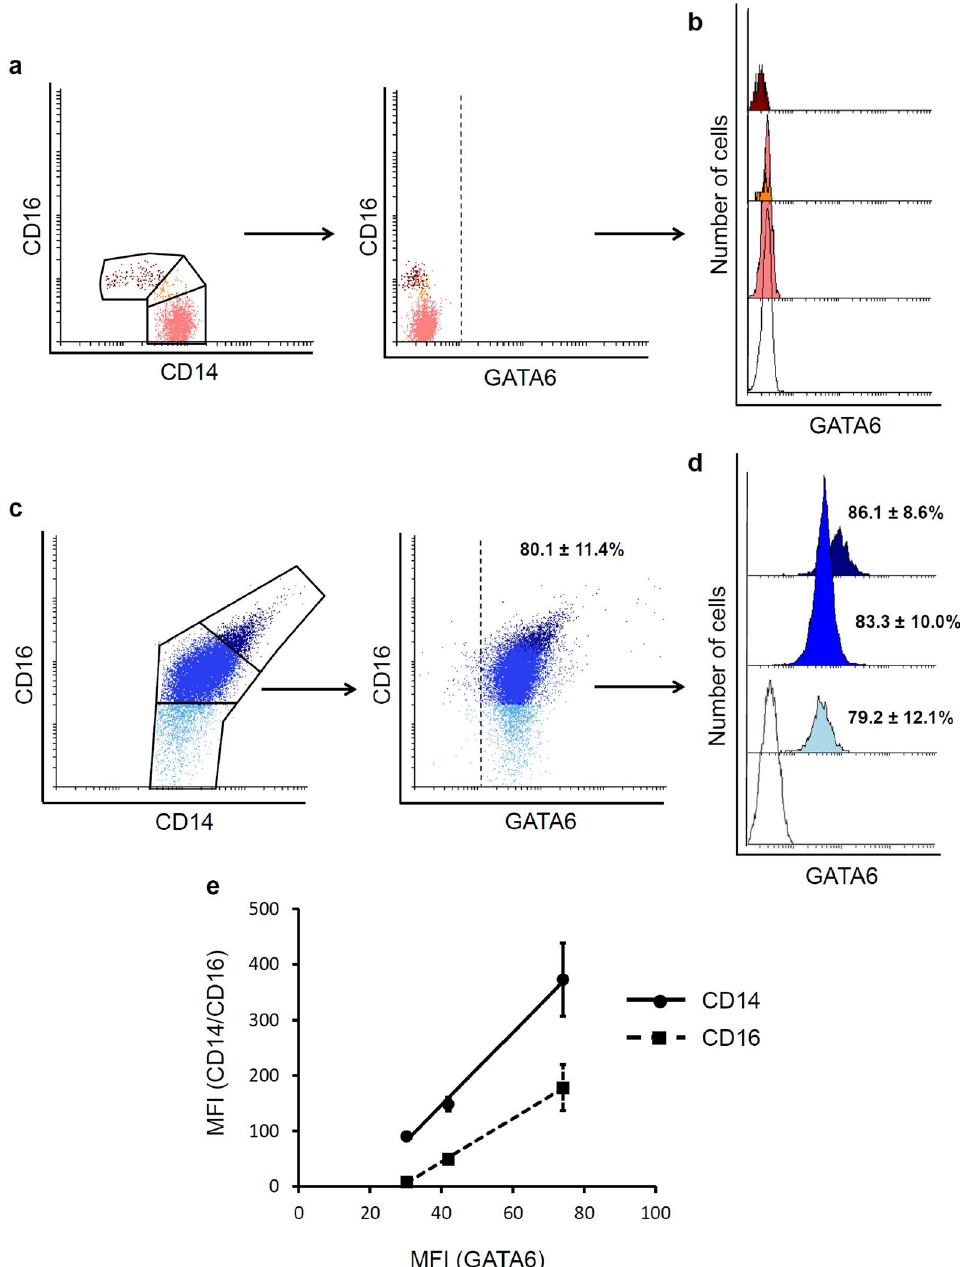
Figure 3. Flow cytometry analysis of the intracellular expression of transcription factor GATA6 in human peritoneal monocytes/macrophages. Representative FACS dot-plots of the gating strategy for blood monocytes subsets based on CD14/CD16 expression and the level of intracellular expression of transcription factor GATA6 in blood monocytes are displayed ( a ). Representative FACS histograms of intracellular expression of transcription factor GATA6 in the three blood monocytes subsets are shown partially overlaid ( b ). Representative FACS dot- plots of the gating strategy of peritoneal subsets based on CD14/CD16 expression, and the level of intracellular expression of transcription factor GATA6 in peritoneal monocytes/macrophages are also displayed ( c ). Representative FACS histograms partially overlaid corresponding to GATA6 intracellular expression in the three different peritoneal monocytes/macrophages subsets are shown ( d ). Percentages of GATA6 positive cells present in peritoneum, indicated as mean ± SEM, are shown next to the corresponding histogram. Percentages referred to the totality (100%) of monocyte/macrophages into the correspondent subset. Empty histograms correspond to FMO control-PE and coloured histograms to GATA6-PE in blood (pink: CD14 ++ CD16 − classic subset; orange: CD14 ++ CD16 + intermediate subset; dark red: CD14 + /low CD16 + non-classical subset) or peritoneum (light blue: CD14 ++ CD16 − subset; bright blue: CD14 ++ CD16 + subset; dark blue: CD14 high CD16 high subset). Correlation analysis of GATA6 intensity expression (MFI) related to the corresponding MFI of CD14 (black circles) and CD16 (black squares) for each monocyte/macrophage subset is displayed ( e